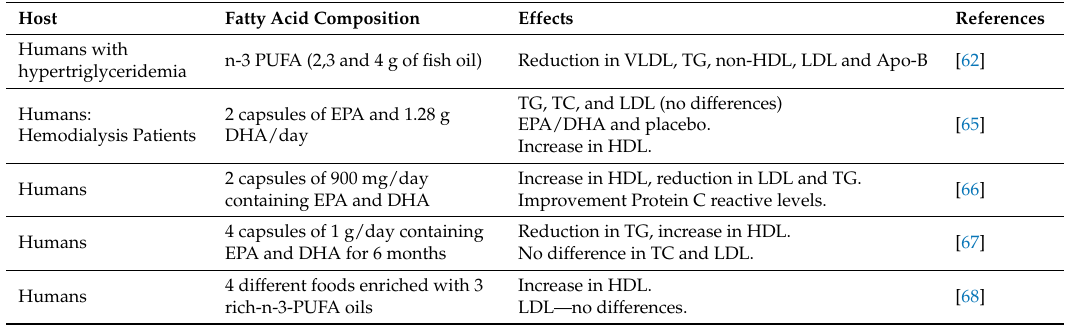
Table 3. Effects of consuming different types of fatty acids during human studies on